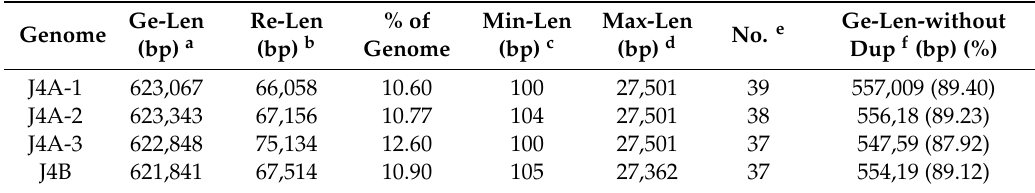
Table 3. Lengths and percentages of repeats ( ≥ 100 bp).